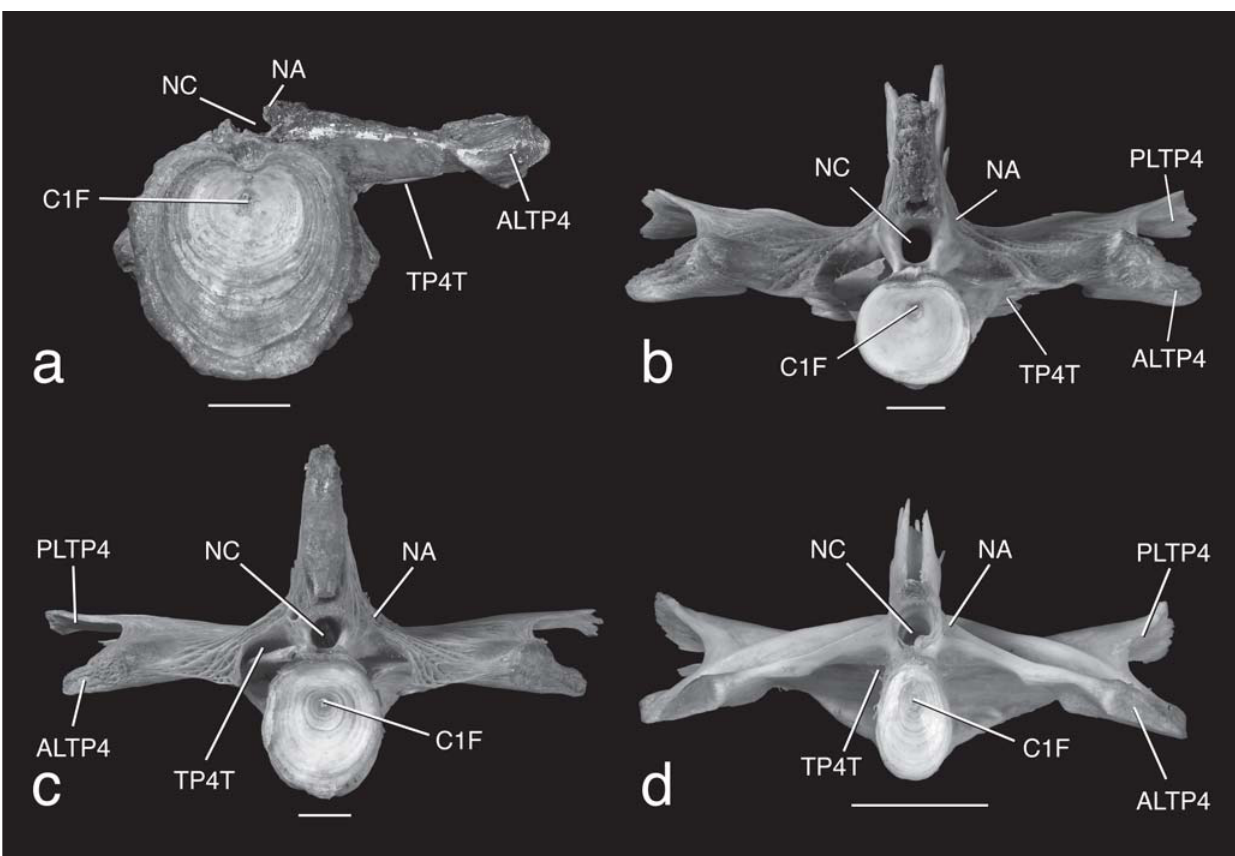
Fig. 6. Weberian complexes in anterior view of the fossil and modern Brachyplatystoma species, a, B. promagdalena , IGM183062, b, B. filamentosum , DU F1052, c, B. rousseauxii , DU F1078, d, B. vaillantii , DU F1034. Scale bars equal to 1 cm. Abbreviations as in Figs. 1 and 2 plus: C1F, central focus of growth rings; TP4T, trough below fourth transverse